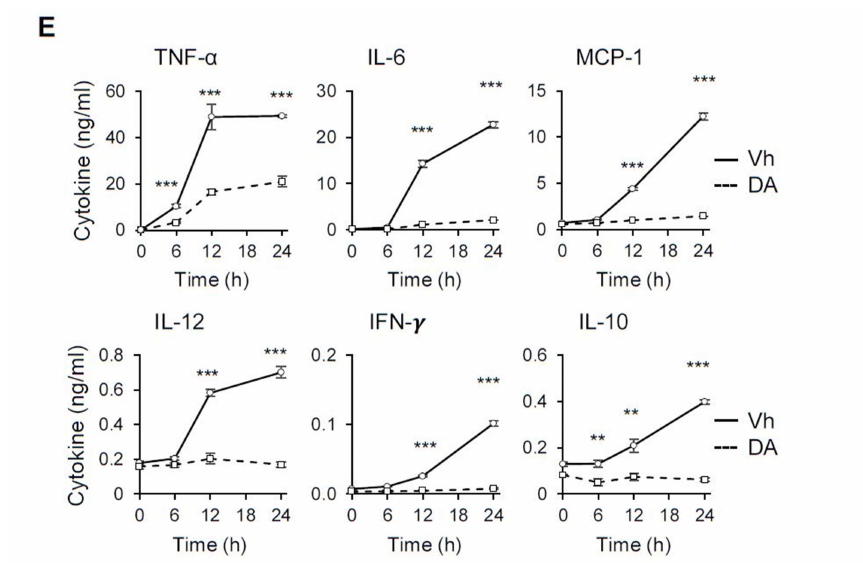
Figure 4. DA promotes the bacterial killing activity of macrophages while suppressing the induction of pro-inflammatory cytokines. BMDMs were pretreated with 40 µ M DA and incubated with 3 × 10 6 CFUs MRSA. Some macrophages were incubated with MRSA in the presence of 5 mM n -acetylcysteine (NAC). ( A , B ) Cells were washed to remove cell-free bacteria 0.5 h after infection with MRSA and incubated for additional 1.5 h in a new antibiotic-free medium. BMDMs were lysed, and the bacterial titer at the indicated times (0.5 h and 2.0 h) after the MRSA infection were determined as CFU; n = 5 ( A ). ( B ) Bacterial killing efficiency was calculated as described in the “Materials and Methods”, and the mean ( ± S.D.) values are shown. ( C , D ) BMDMs were pretreated with DA and infected with 3 × 10 6 CFUs MRSA for 2 h in the presence or absence of NAC. ROS levels in BMDMs were measured using H 2 DCFDA and flow cytometry (C). Amounts of NO in the culture supernatant were determined as nitrite levels ( D ). ( E ) Cytokine production of BMDMs in response to